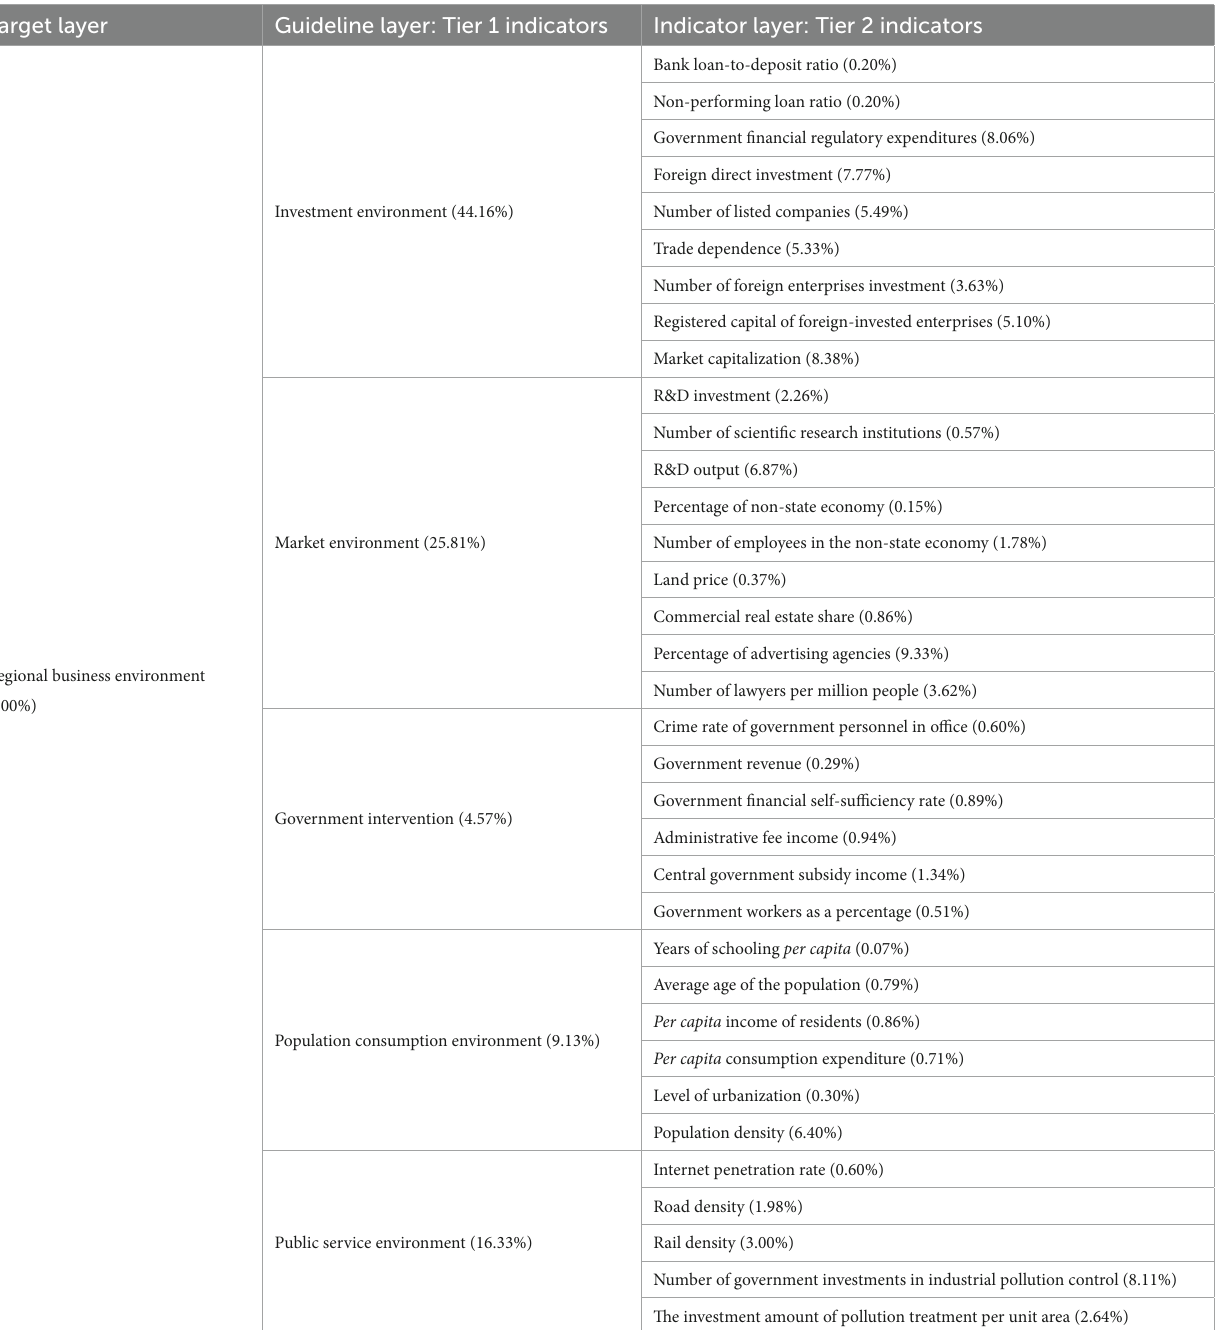
TABLE 1 Business environment index system for Chinese provinces. Target layer Guideline layer: Tier 1